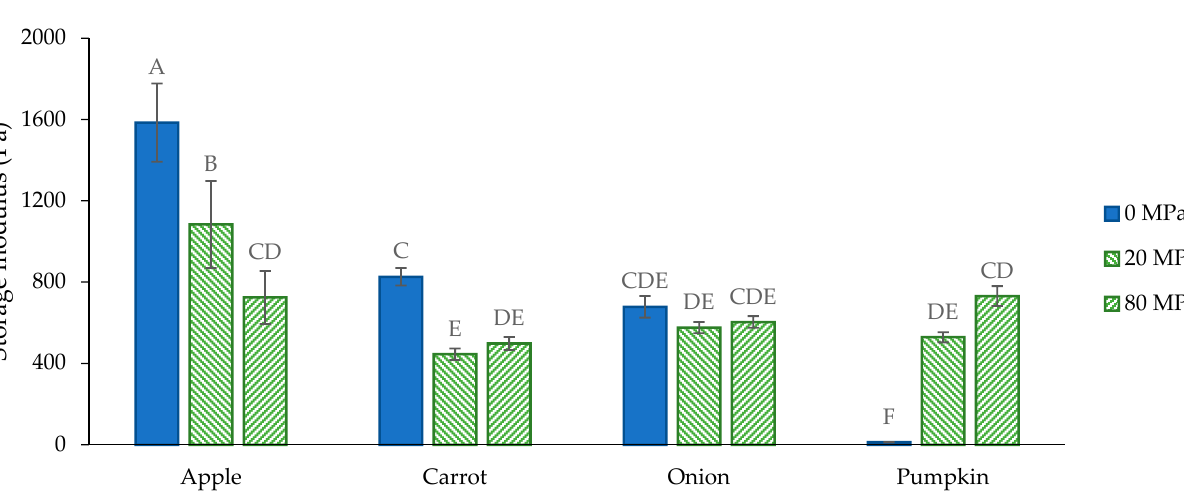
Figure 5. Critical strain of the suspensions (2% w / w ) prepared with the acid-unextractable fraction of apple, carrot, onion and pumpkin before (0 MPa) and after high-pressure homogenization at 20 and 80 MPa at 10 rad/s angular frequency; data are from the strain sweep. The error bars represent the standard deviation (n = 2 × 2) and significant differences are indicated by different letters (Tukey test, p < 0.05).